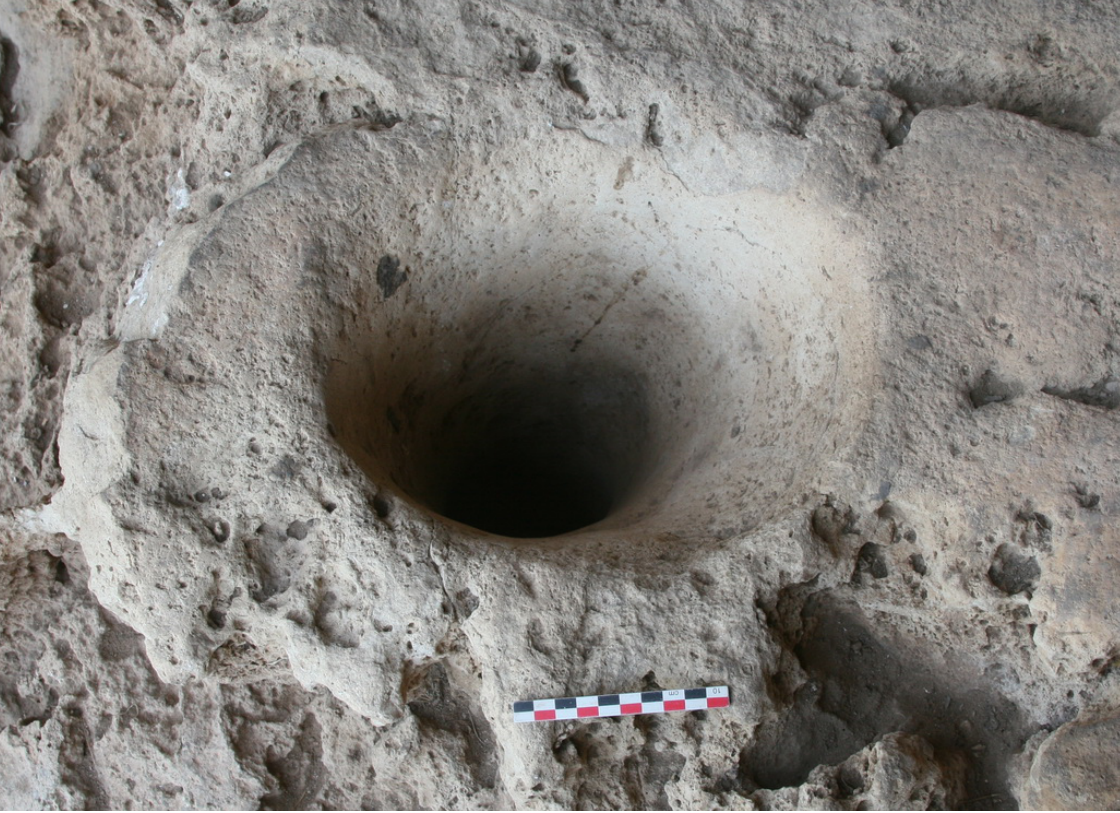
Figure 4. Top view of Mortar